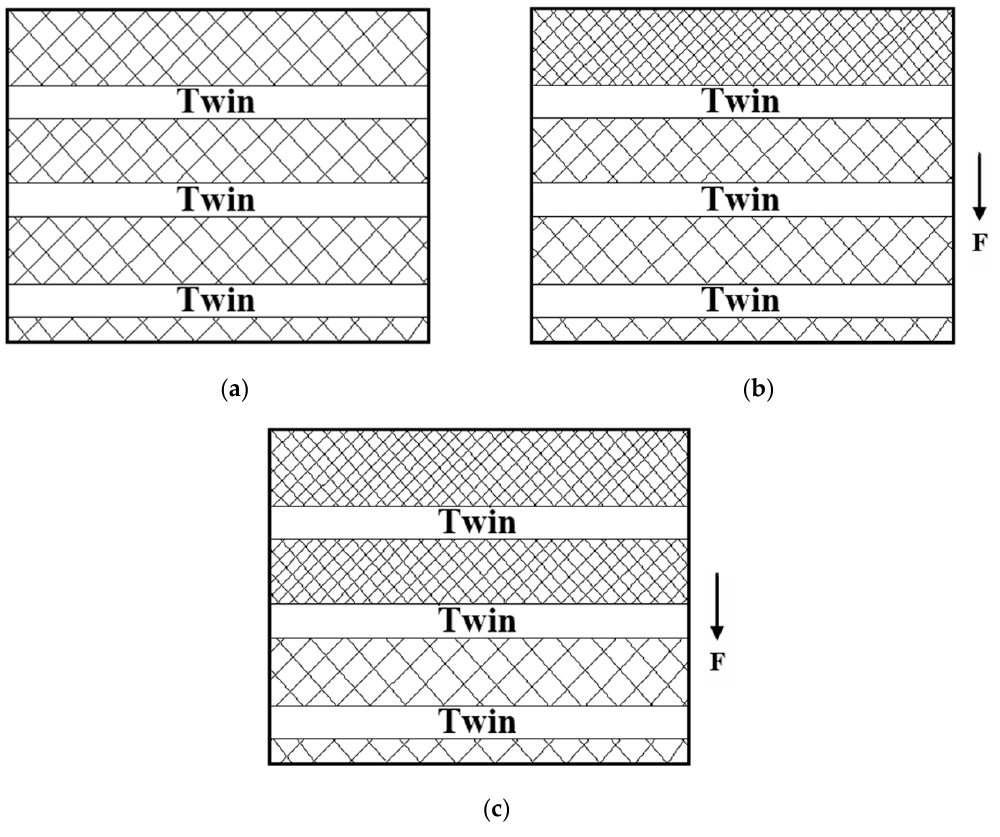
Figure 8. Schematic images for the microstructure change of the serration behavior in the deformed NiCrFeCoMn HEA. ( a ) Twin layers in the deformed sample; ( b ) the movement of dislocations is hindered by the twin layers; ( c ) dislocations overcome the twin layers.